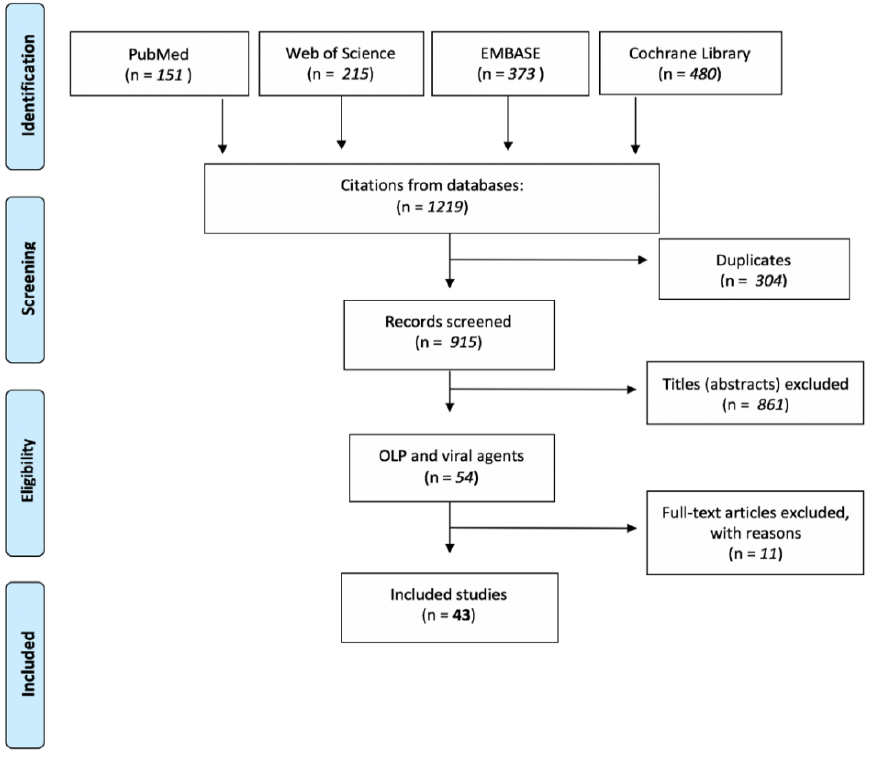
Figure 1. The flowchart explicates the steps made during the selection